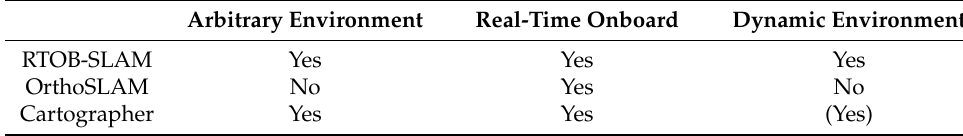
Table 1. Comparison between RTOB-SLAM and two widely used